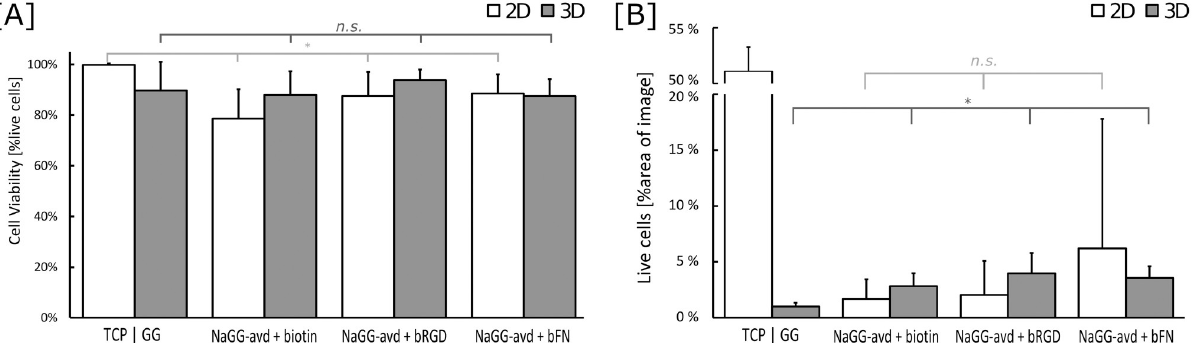
Fig 6. [A] Cell viability and [B] spreading of WI-38 fibroblasts in different materials as calculated from LIVE/DEAD 1 stain image analysis. Control materials are tissue culture plastic (TCP, 2D) and unmodified, unpurified GG (3D). Bars represent mean values ± SD, n � 10. [A] Cell viability (%live cells vs sum of live and dead cells) demonstrates that all 3D samples (GG, NaGG-avd) are statistically the same (p = 0.09), while the 2D samples (TCP, NaGG-avd) are statistically different (p � < 0.05). Similarly, cell spreading (area% of live cells in image) demonstrates no significant difference between 2D GG based samples (p = 0.20), while there is significant difference between 3D samples (p � = 3.94 x10 -8 ).